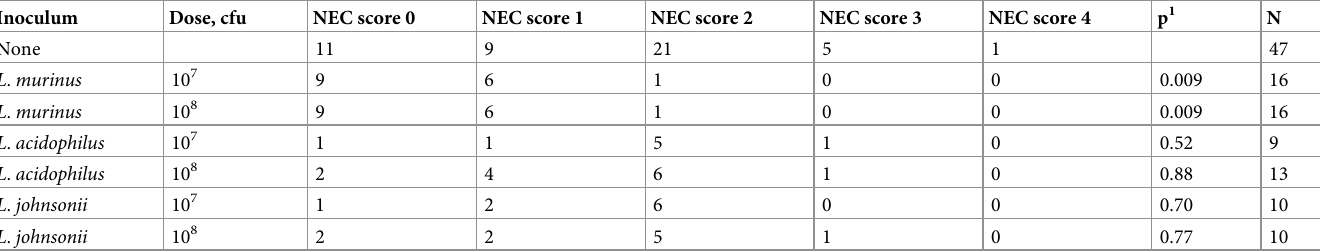
Table 1. Effects of inoculation with lactobacilli on spontaneous NEC scores. Inoculum